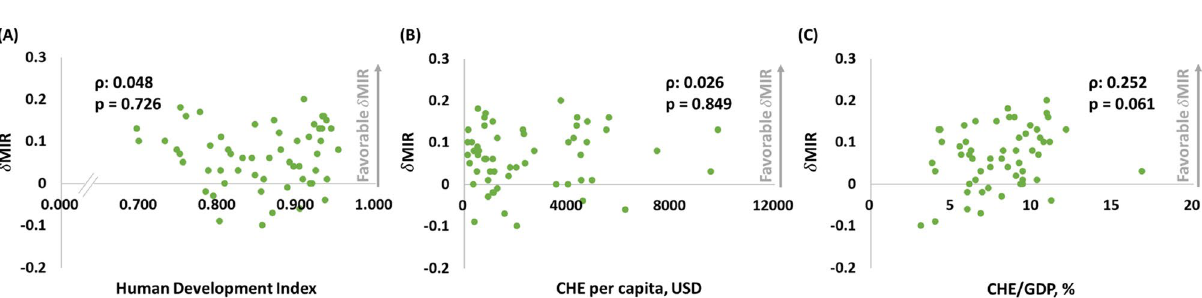
Figure 2. ( A ) HDI, ( B ) CHE per capita, and ( C ) CHE/GDP are significantly associated with the MIR in KC.